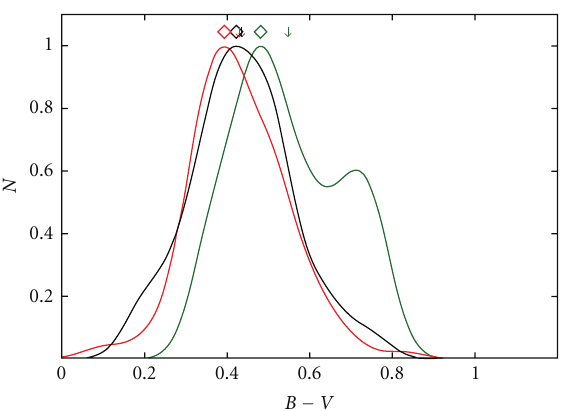
Figure 13: Normalized histograms of B − V color. This sample is in black, the RC3 late-type galaxies are in green, and Hunter and Elmegreen and van Zee dwarf galaxies are in red. Our sample has a similar mean and range as the dwarf galaxy sample, both are significantly bluer than the RC3 sample.